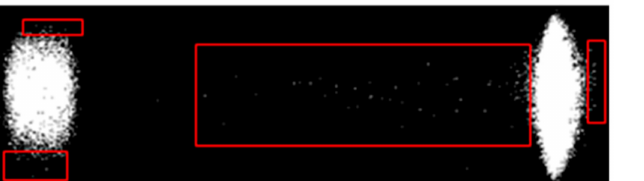
Figure 8. The dot-pixels obtained from the image thresholding. These are removed by applying an area filter over the acquired map.